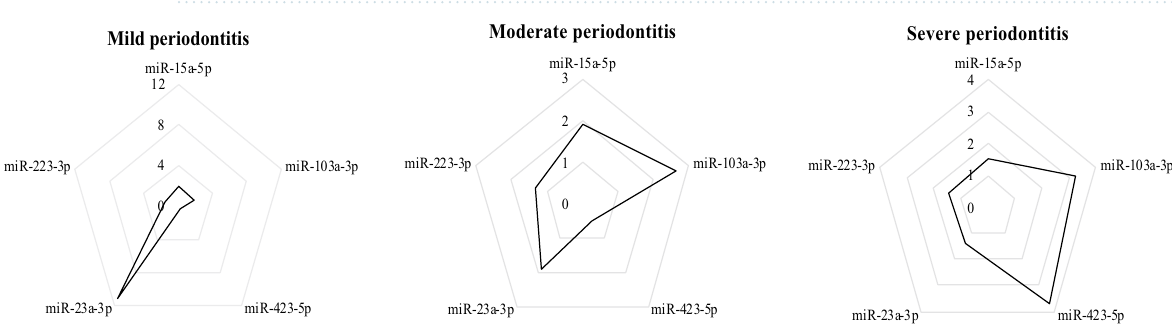
Figure 2. Boxplots of relative expression levels of ( a ) miR-15a-5p, ( b ) miR-223-3p, ( c ) miR-23a-3p, ( d ) miR- 103a-3p and ( e ) miR-423-5p in periodontal disease patients GCF sample, at mild, moderate and severe disease stages. Data are reported as fold change ± C.I. with respect to HC, equal to 1. The statistical significances shown are *p < 0.05; **p < 0.01; ***p < 0.001. Data were analyzed using Stata version 15 and GraphPad Prism 6.